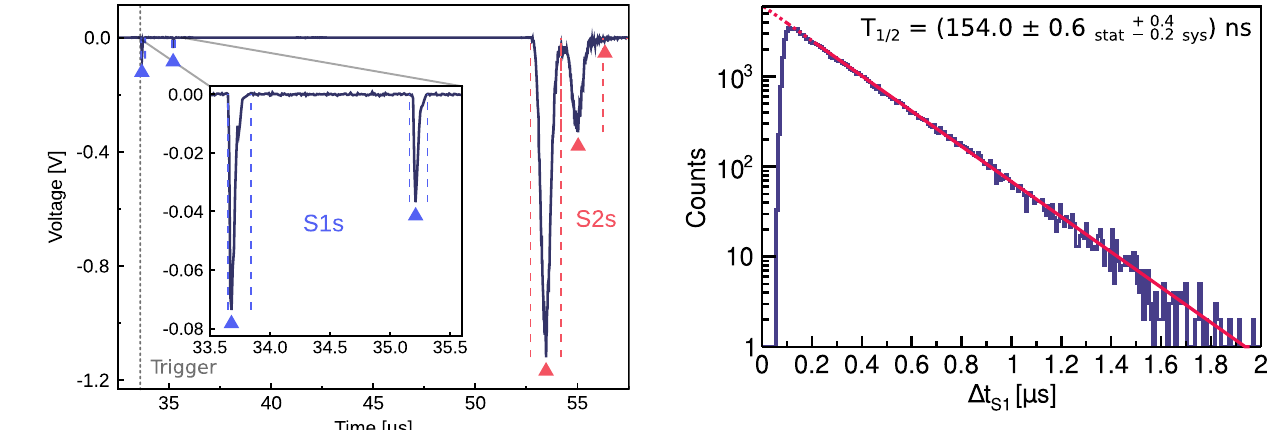
Fig. 8 83m Kr candidate event. The signals and the intervals as identi- fied by the data processor are shown. The two main S2 signals are fol- lowed by a small single-electron S2 signal which is caused by delayed electron extraction or ionization of impurities inside the TPC the HeXe signal feedthroughs to a custom-made voltage amplifier with an amplification factor of ∼ 2 per channel.